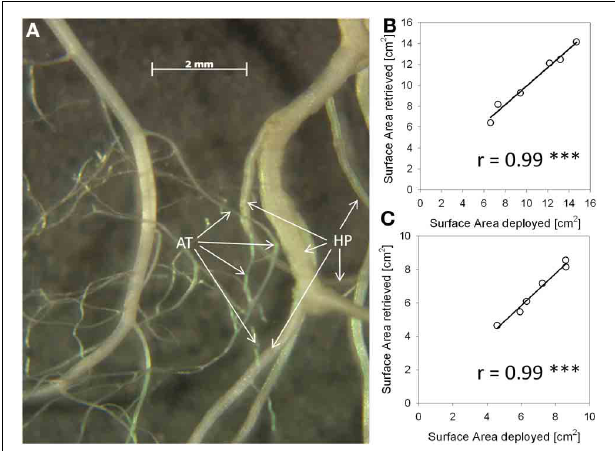
FIGURE A1 | Method validation for distinction of roots of the two experimental species. Both in the experiment and in this validation setup roots were distinguished by visual inspection on the grounds of root morphological features. (A) : Photograph of water-floating roots of Arabidopsis thaliana (AT) and Hieracium pilosella (HP). (B) : Correlation results in A. thaliana root retrieval test of deployed vs. retrieved root fragments before and after thoroughly mixing them with root fragments of H. pilosella . Roots were placed in a transparent water basin, scanned and analysed for root surface area by WinRhizo imaging software. (C) : Corresponding results for H. pilosella . The number of replicates was n =